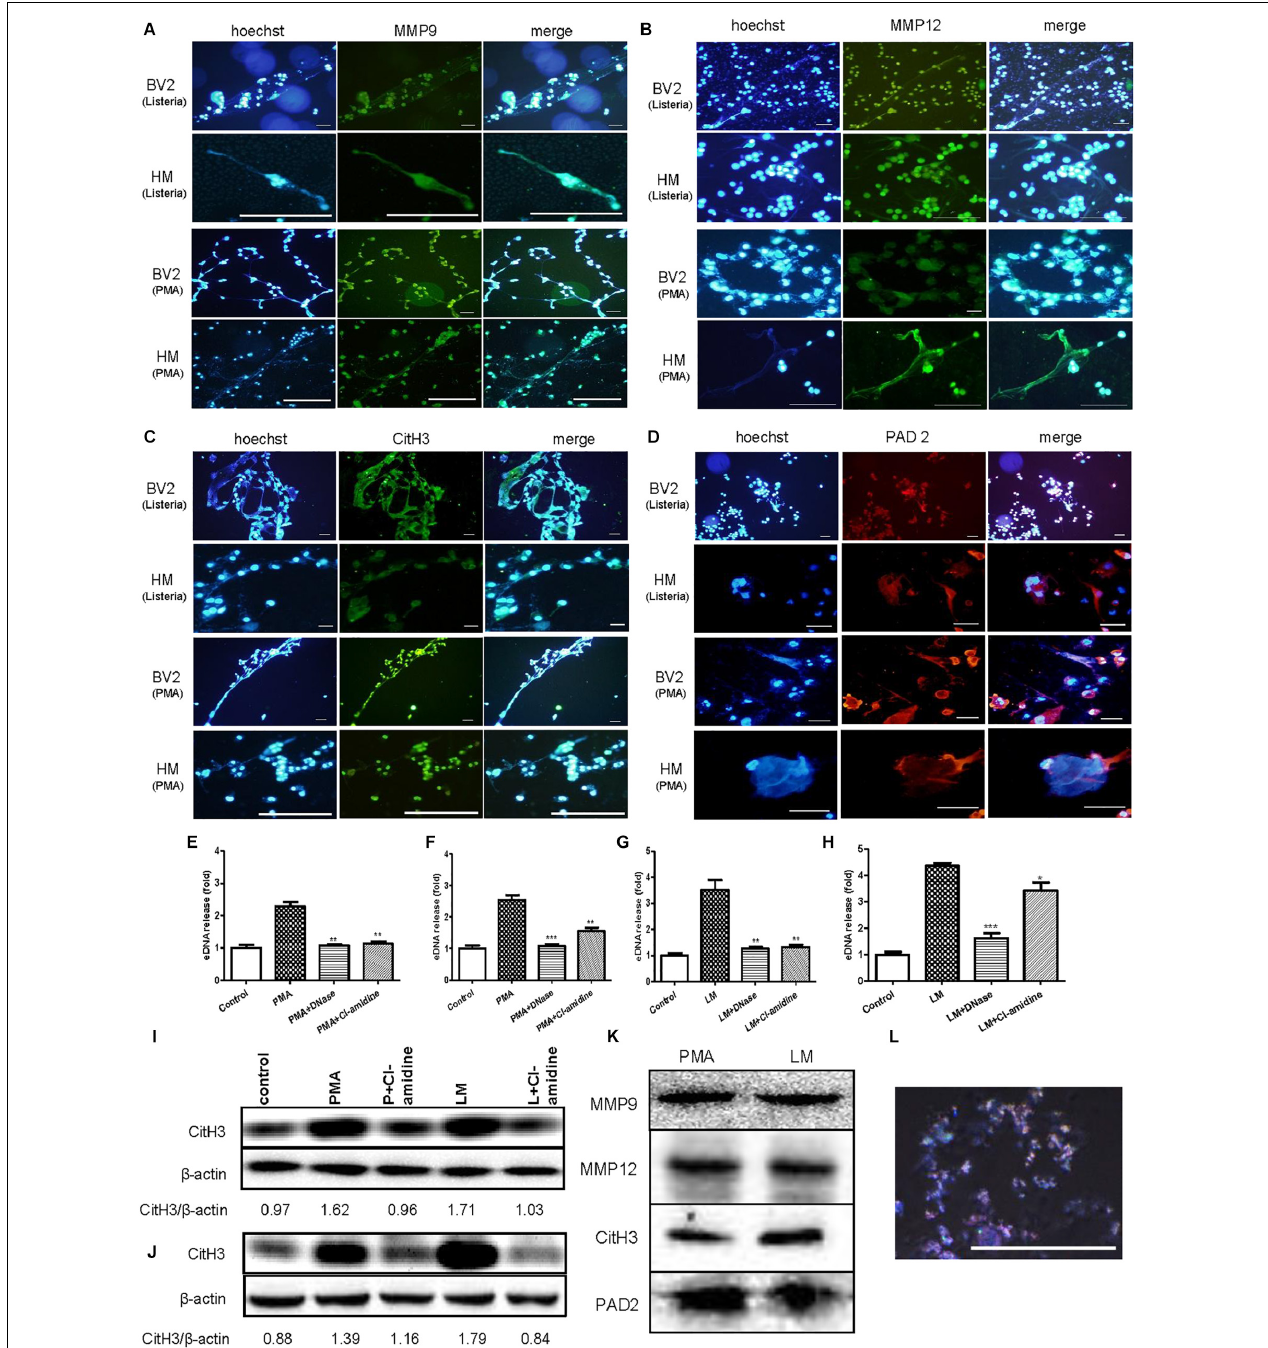
FIGURE 4 | eDNA, MMPs, Citrullinated histone H3 and PAD2 are major components of MiETs. Anti-MMP9 antibody (A) , anti-MMP12 antibody (B) and eDNA staining of mouse and human microglia following PMA treatment or Listeria treatment. Anti-histone H3 antibody and eDNA staining of the two cell lines following PMA treatment or Listeria treatment (C) . Anti-PAD2 antibody and eDNA staining of the two cell lines following PMA treatment or Listeria treatment (D) . Scale bars = 50 µ m. Mouse or human microglia were pre-treated with DNase I (40 U/ml) or Cl-amidine (100 µ M). Next, mouse microglia were exposed to PMA (E) or Listeria (G) . Pre-treated human microglia were also incubated with PMA (F) or Listeria (H) . The cells were stained with Sytox green and were detected by a plate reader. ∗ p < 0.05, ∗∗ p < 0.01, ∗∗∗ p < 0.001, compared with the PMA- or Listeria-treated cells. The data are representative of triplicate experiments and are presented as the mean value ± SEM. Mouse microglia (I) and human microglia (J) were pre-treated with 100 µ M Cl-amidine for 30 min. Next, PMA or Listeria was added to the cells for 2 h. Western blotting was used to assess the citrullination of histone H3. The western blotting results demonstrated that MMP9, MMP12, citrullinated histone H3 and PAD2 were the components in the vesicles (K) . Vesicles marked by rabbit anti-mouse CD9-AF647 antibody (red) and DNA stained with Hoechst 33342 (blue), as observed by confocal microscopy (L) .